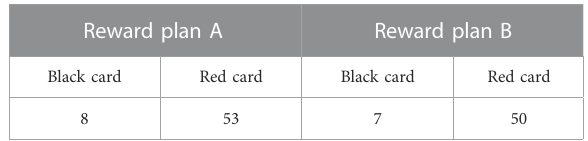
TABLE 3 Validate test, unit: